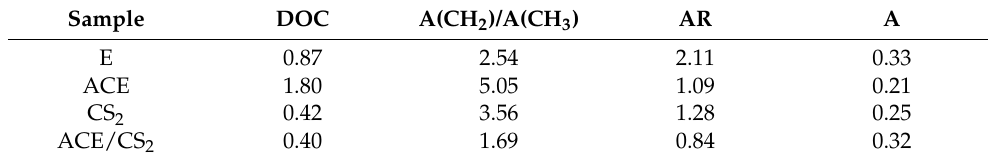
Table 11. Structural parameters of coal tar residue and its three extractive residues.